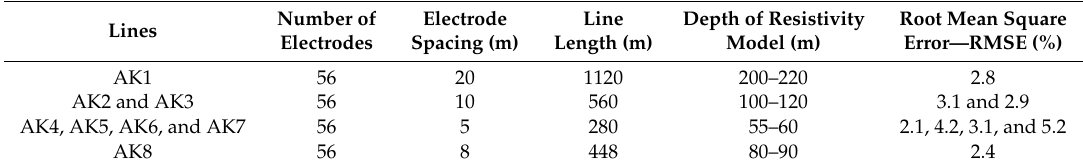
Figure 6. Location of the geophysical survey lines and the springs. Table 2. Information about the geophysical survey